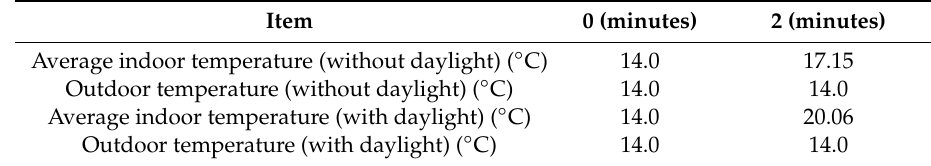
Table 7. Winter simulation